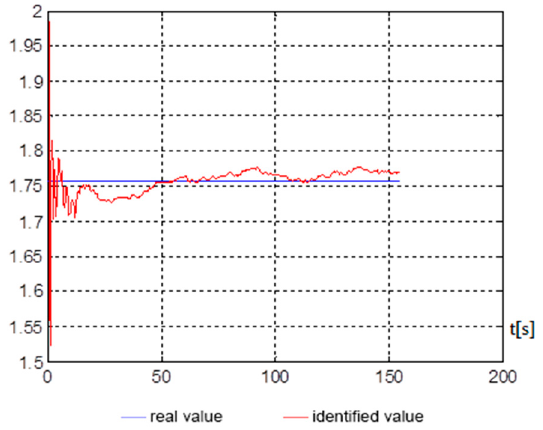
Figure 8. m y assessment over Figure 8. m assessment over time. y